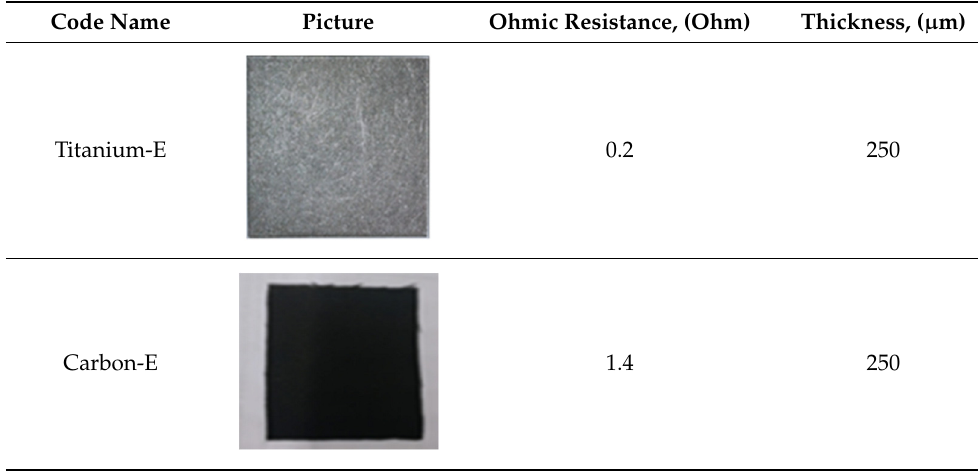
Table 1. Types of electrodes used for the cathode side.